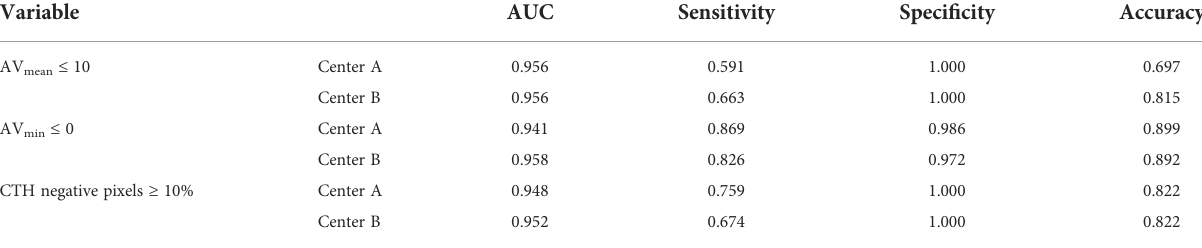
TABLE 2 Comparison of diagnostic ef fi cacy of three parameters for adenoma in two centers. Variable